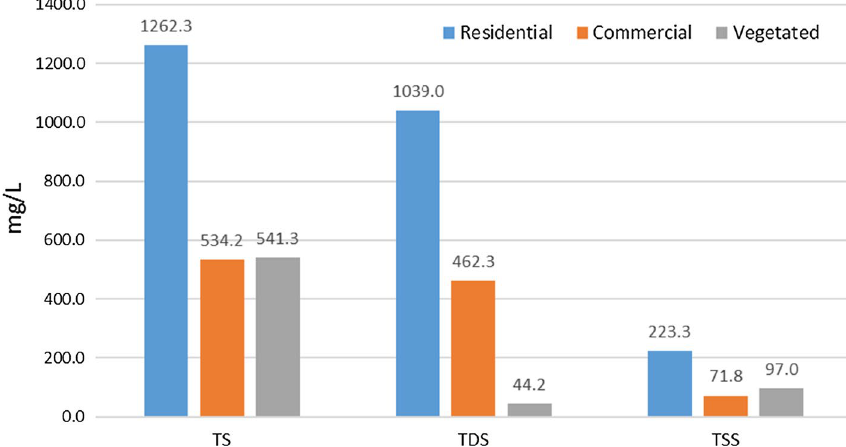
Fig. 6 Variation in TS, TDS and